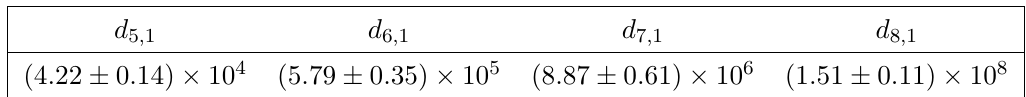
Table 3. Final values for the perturbative coefficients of Π( s ) , d n, 1 , from the Padé and D-log Padé approximants to the perturbative expansions of Im Π( s ) and Π 00 ( s ) in QCD ( MS scheme, N f = 5